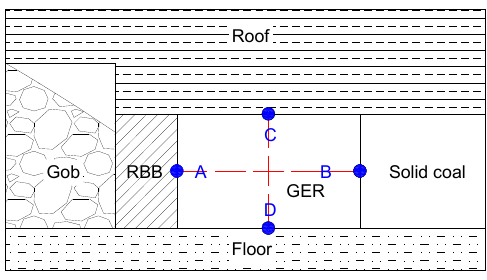
Figure 7. Schematic diagram for GER surrounding rock deformation monitoring.